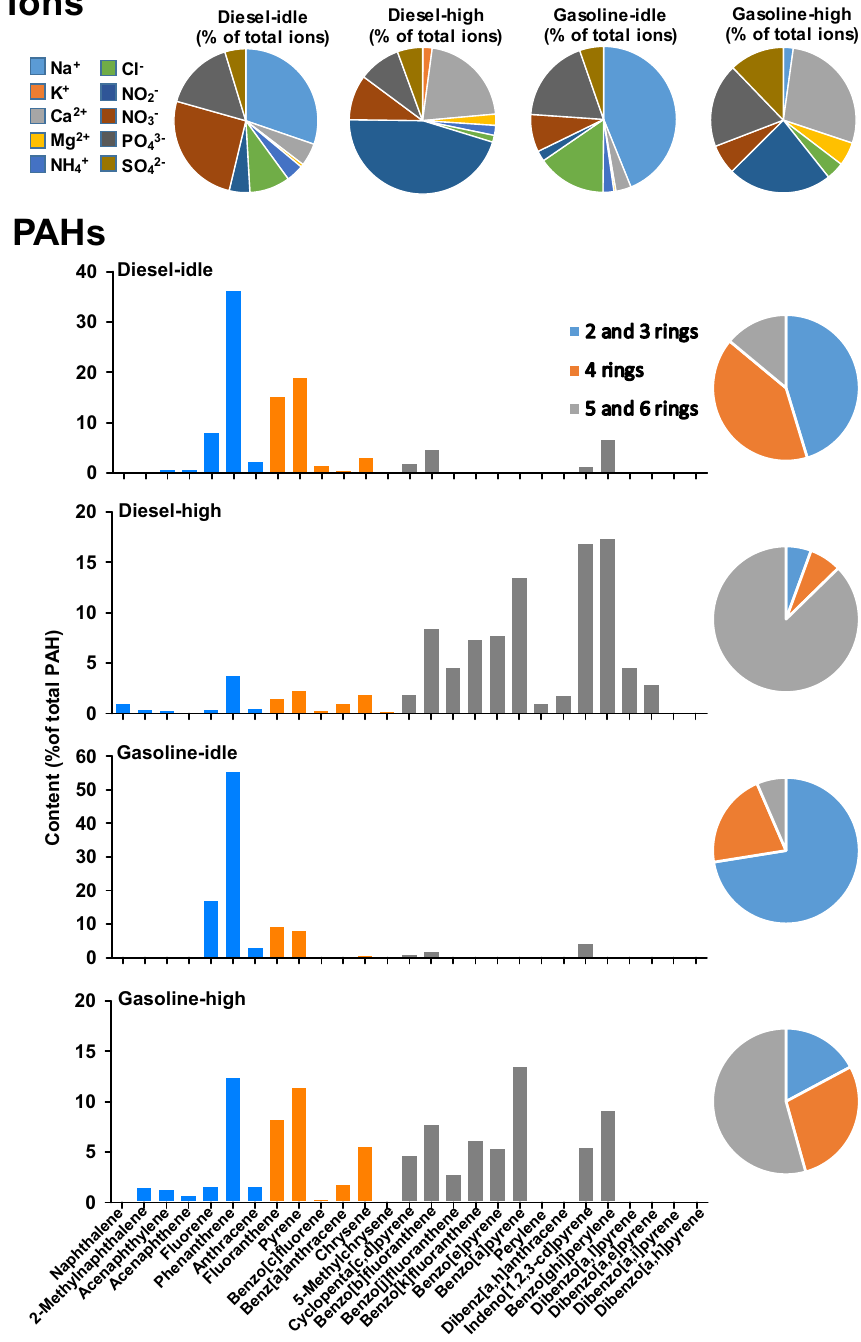
Figure 3. The relative abundance (%) of individual ion in total ions ( A ) and PAH in total PAHs (B) of PM 2.5 particulates collected from trucks with gasoline or diesel engine under idle and high speeds. In panel ( B ), the percentages of the relative contents of the sub-groups of PAHs with low- (2 and 3 rings), medium- (4 rings), and high-molecular weight (5 and 6 rings) are shown in the pie chart on the